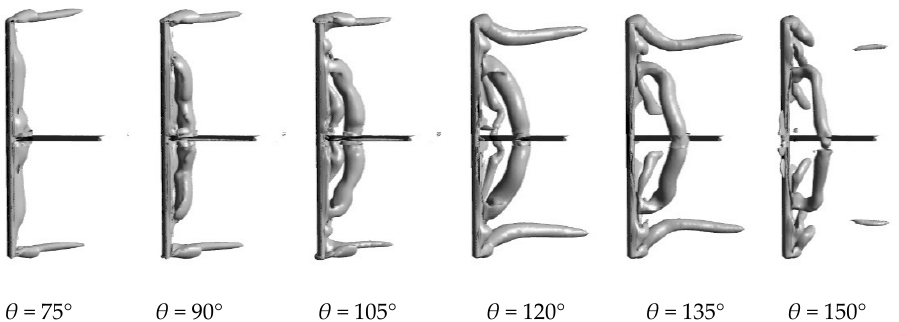
Figure 11. Distribution of vorticity in the Y-axis direction of turbine ( λ = 1.0).